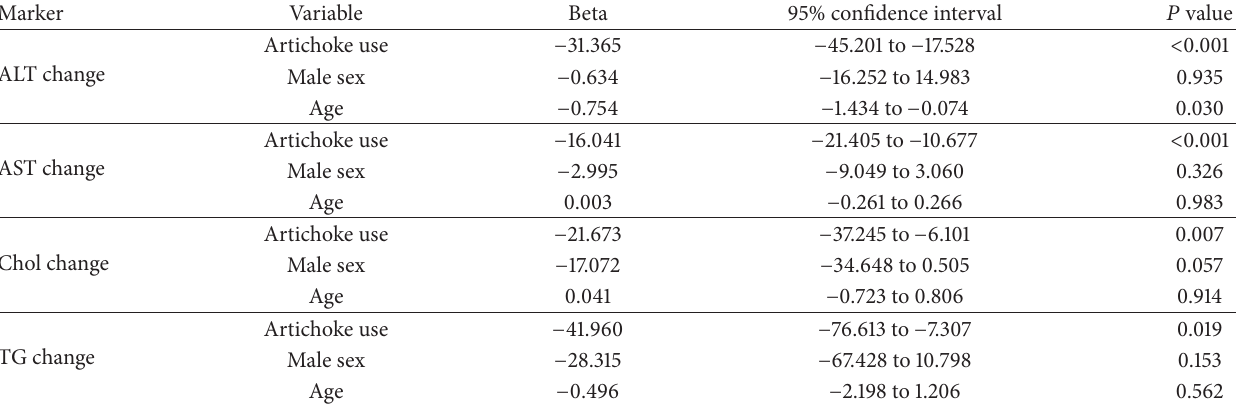
Table 2: Multivariate linear regression models for determining the role of Cynara scolymus use on changes in liver enzymes and lipid profile.